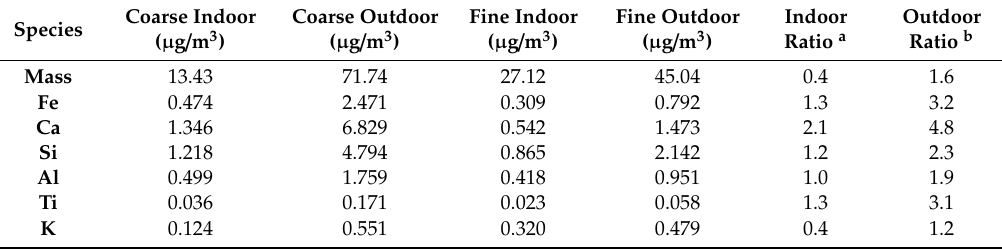
Table 3. Mean indoor and outdoor concentrations and I / O ratios for coarse and fine particle mass, Fe, Ca, Si, Al, Ti, and K measured in 7 matched indoor / outdoor paired samples in Kuwait.